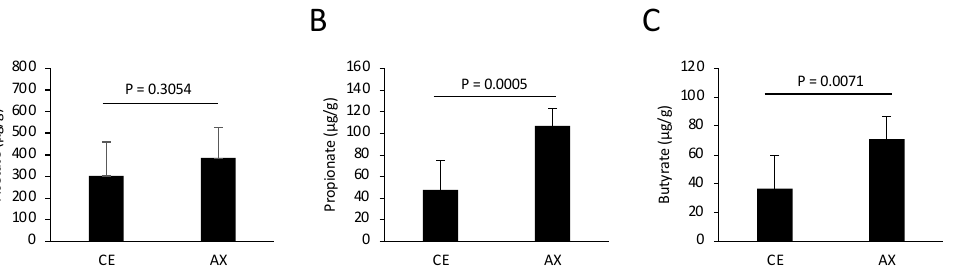
Figure 3. Quantification of fecal SCFAs in the mice fed chows containing CE or AX (n = 8). The feces were collected 2 weeks after feeding and subjected to GC analysis. ( A ) Acetate. ( B ) Propionate. ( C ) Butyrate. Values and error bars indicate the mean ± SD.